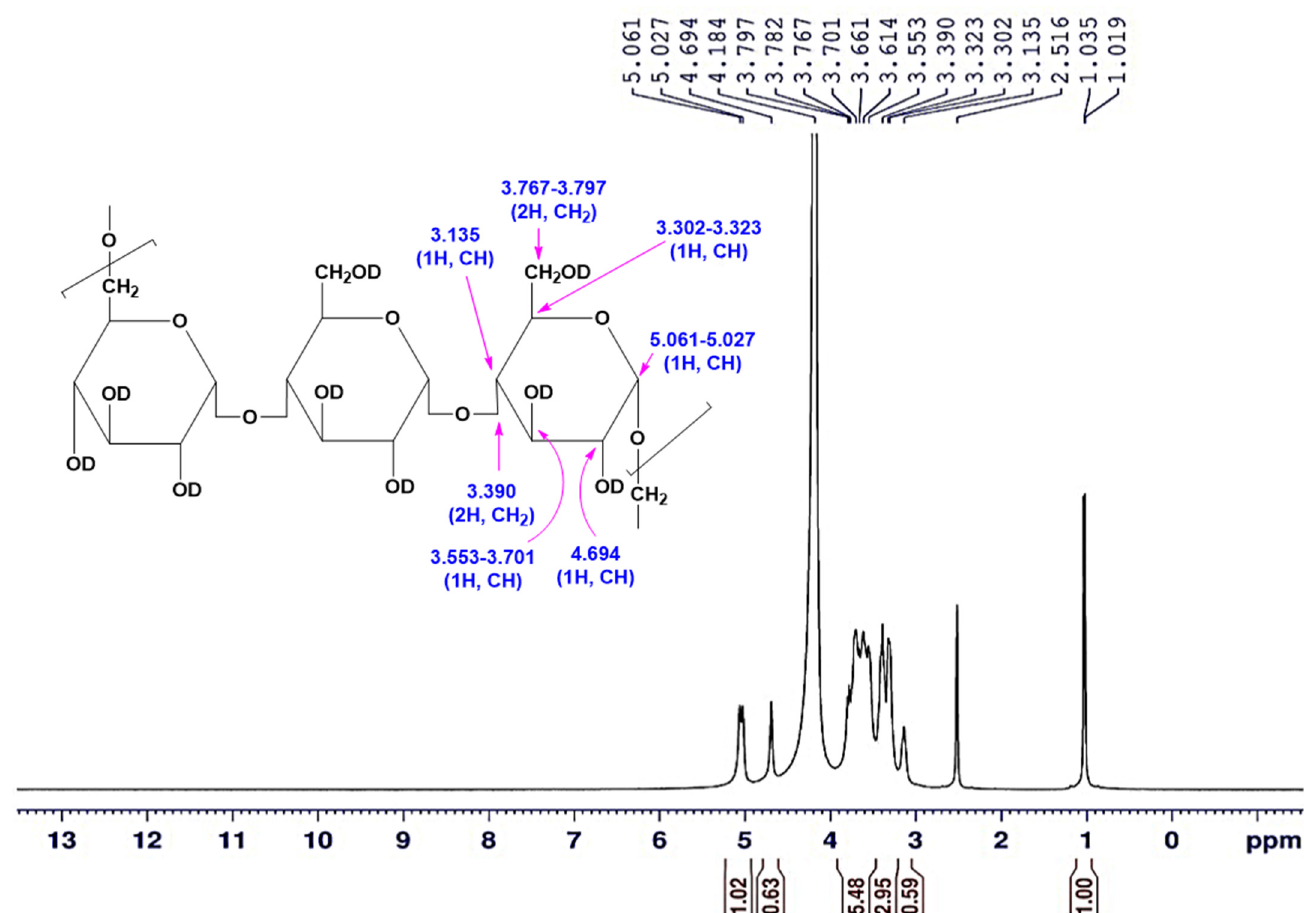
Figure 9. The 1 H-NMR (DMSO- d 6/D 2 O) spectrum of the A. pullulans AKW pullulan.